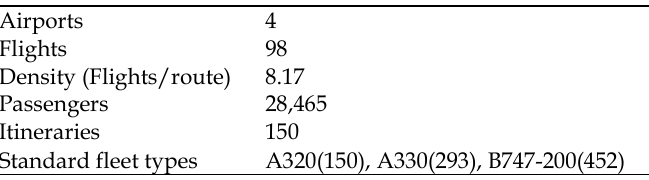
Table 8. Data instance for the peer-to-peer network